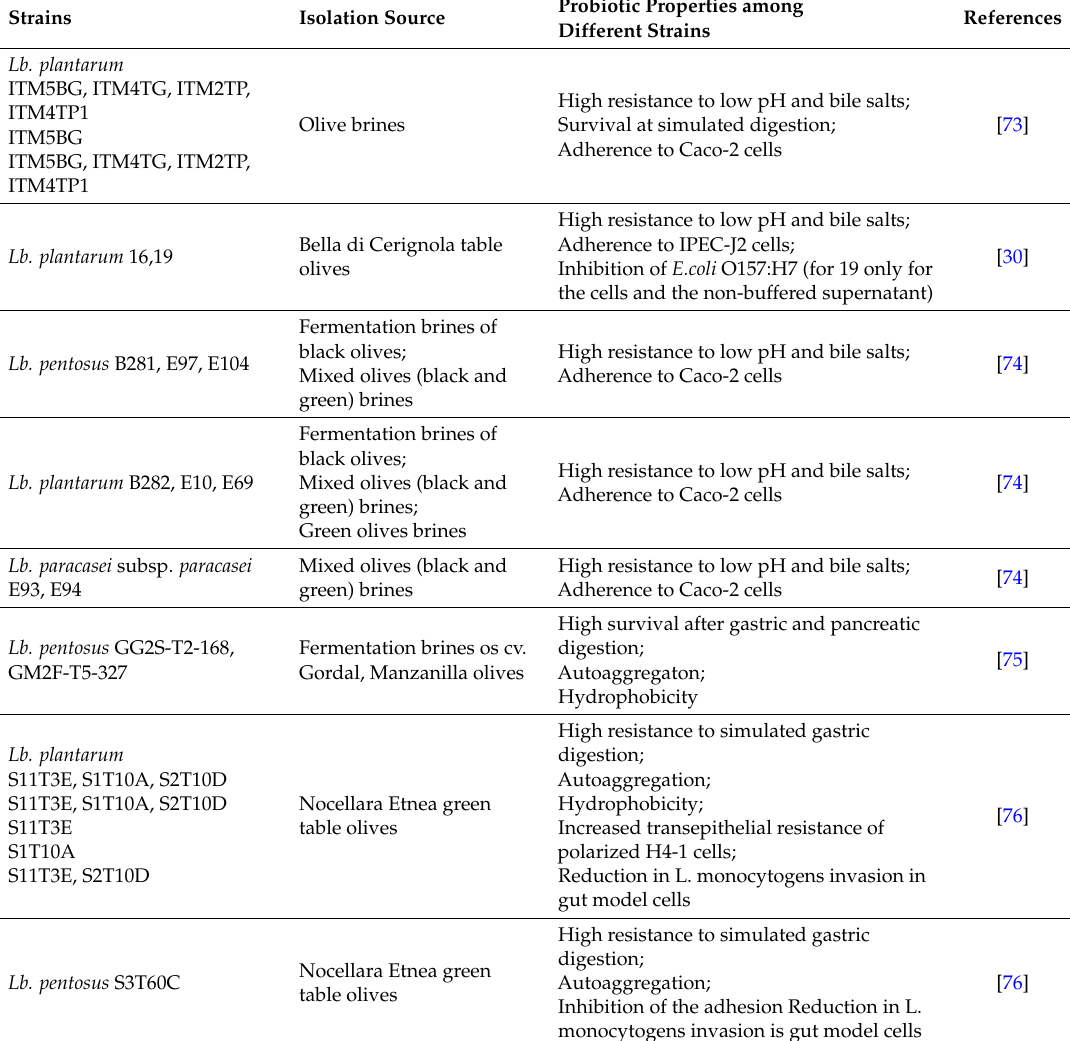
Table 3. Probiotic properties of lactic acid bacteria (LAB) and yeast species isolated from table olives.